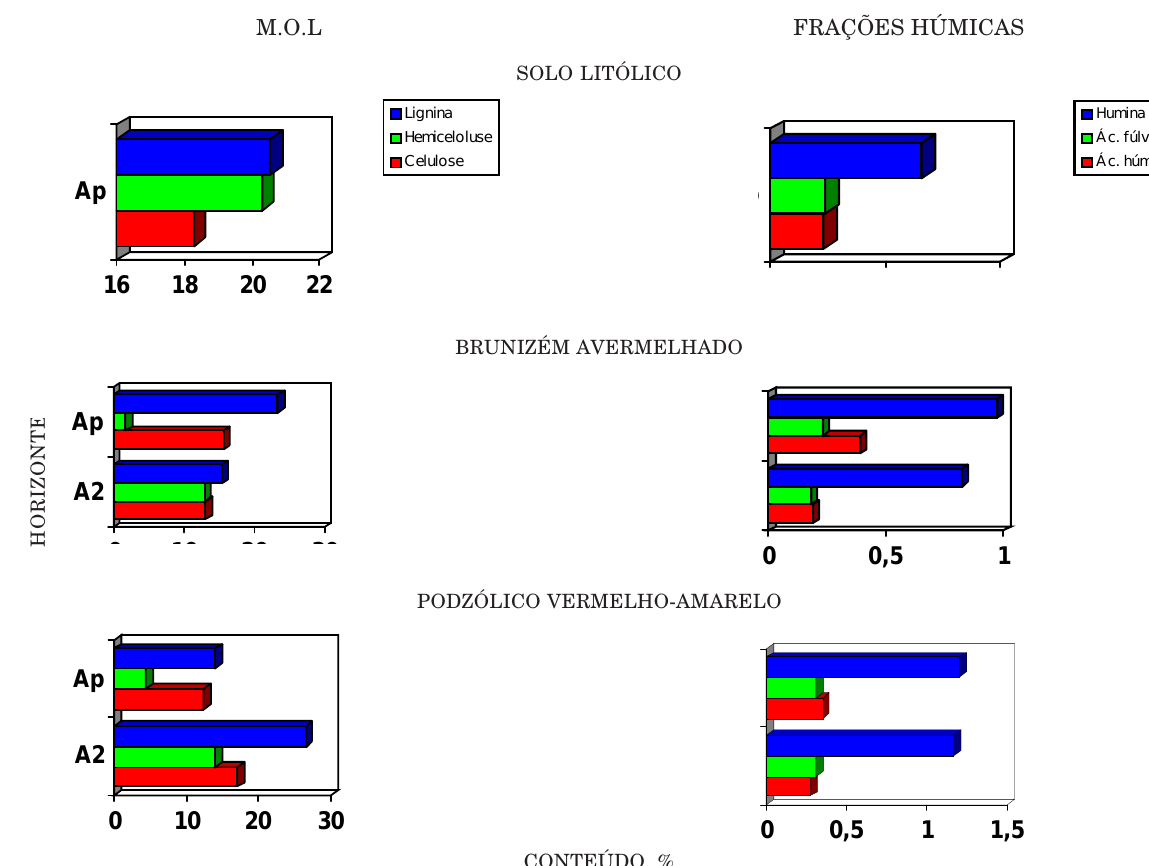
Figura 2. Composição da matéria orgânica leve (M.O.L.) e frações húmicas dos perfis estudados.